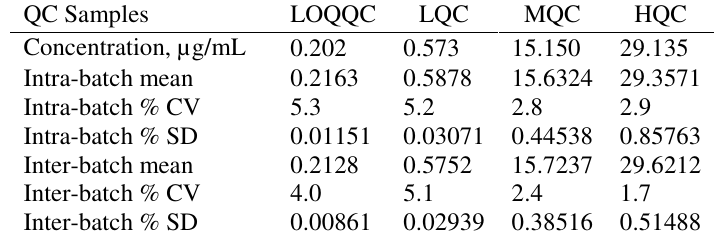
Figure 3. Representative chromatogram of memantine and its internal standard from extracted plasma at LLOQ concentration Table 1. Intra & inter-batch precision and accuracy of memantine in human